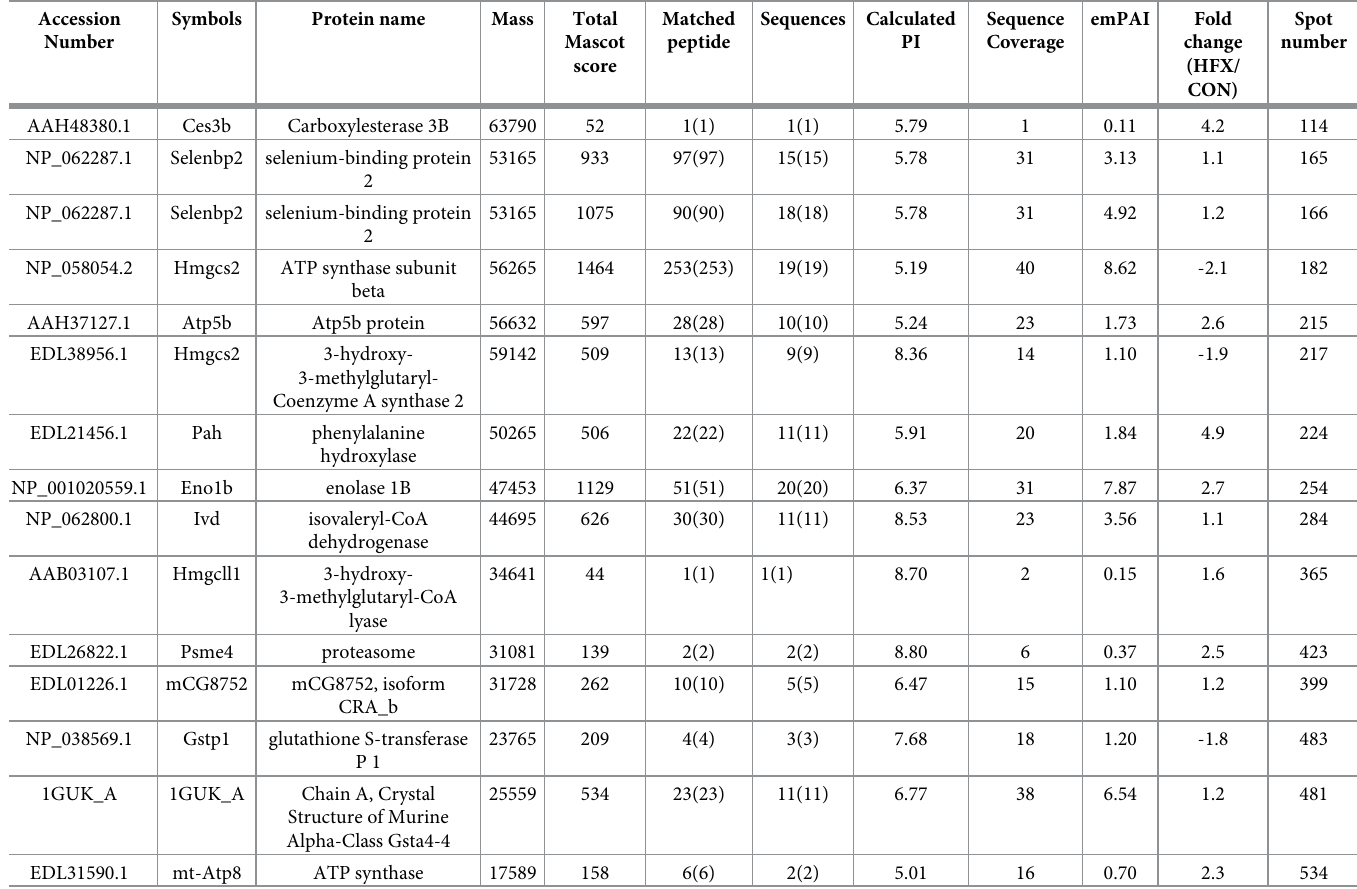
Table 2. Liver proteins differentially expressed in the HFX vs.